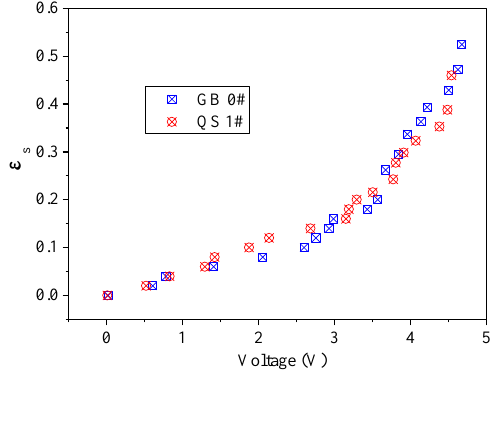
Figure 12. Effect of particle sphericity on the calibration